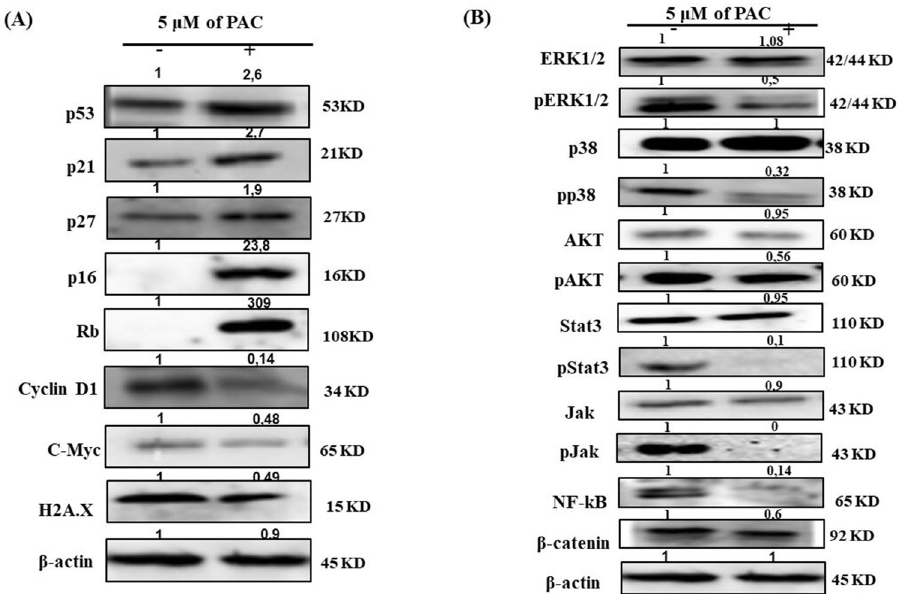
Figure 2. PAC exhibits potent anti-oral cancer properties through targeting several cancer-promoting pathways. ( A ) 5 µM of PAC treatment induces cell-cycle arrest, by increasing the expression of cyclin-dependent kinase inhibitors (CDKIs) such as p21, p27, p16 or p53 and Rb, while it inhibits oncogenes such as cyclin D1 or c-Myc on ca9-22 cells. Also, PAC can to reduce DNA damage on oral cancer cells by inhibition of H2A.X protein expression. ( B ) The effect of PAC on cancer cells is involving specific inhibition of cell proliferation signaling pathways (ERK1/2 phosphorylation, p38, STAT and AKT phosphorylation, NF-κB and Wnt/β- catenin) (n = 3). All Blots for each protein derive from the same experiment and were exposed at same time of phosphor imager